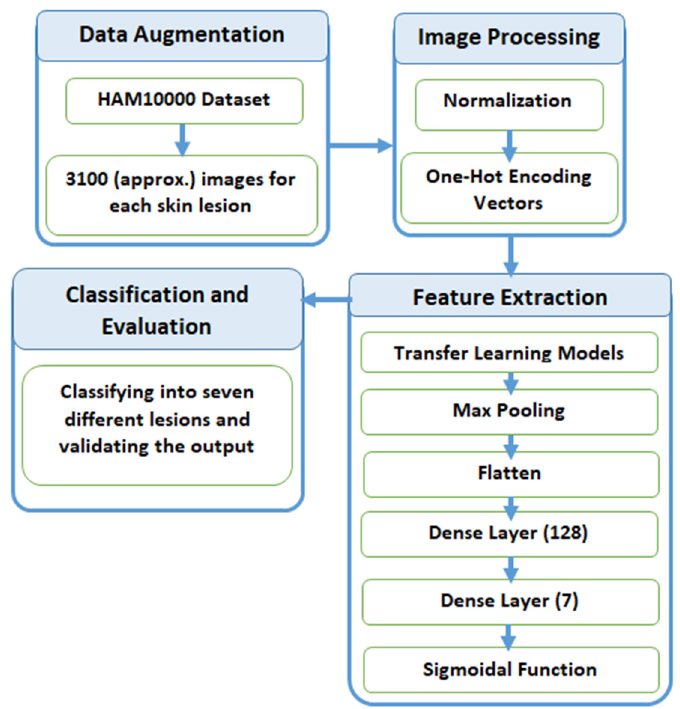
Figure 3. Process flow diagram of the proposed method.